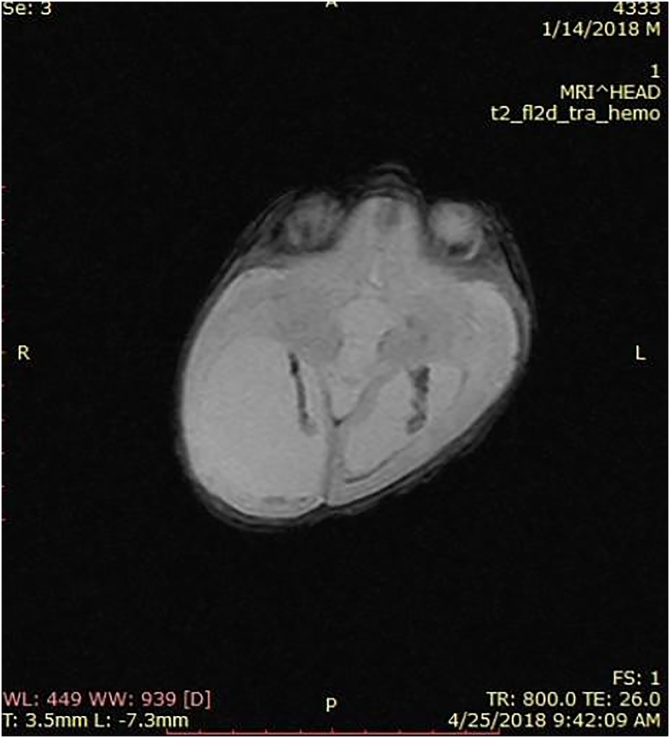
MRI scan, axial view, demonstrating the ventricular enlargement and the hemosiderin deposits within it.